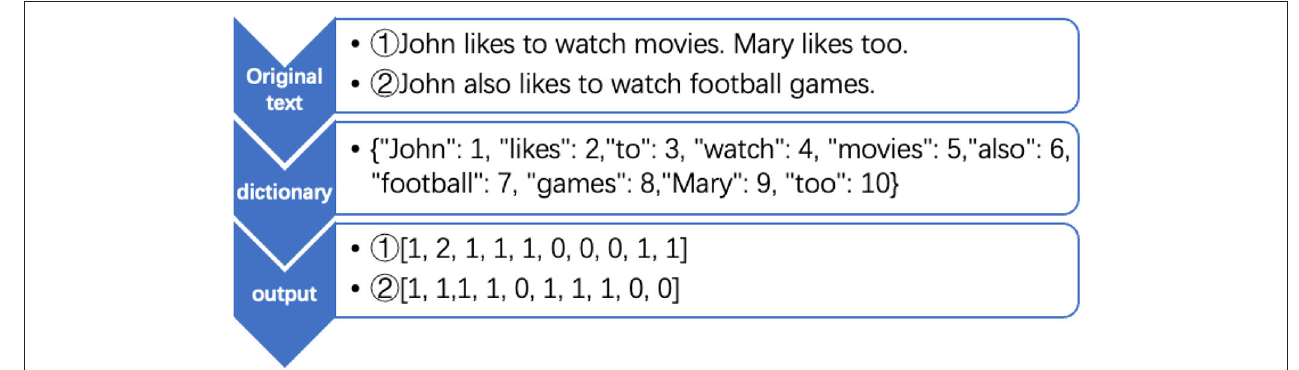
FIGURE 2 | Word2Vec model.